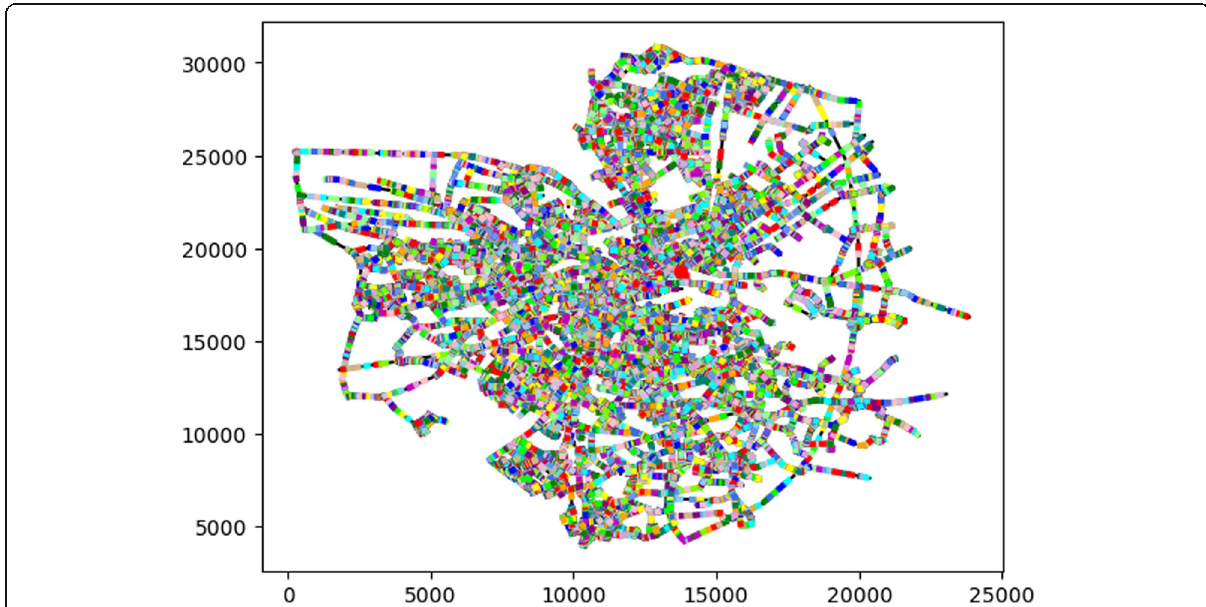
Fig. 8 Road network with semantics information. As shown in this figure, the experimental setting randomly generates 3 to 10 kinds of location